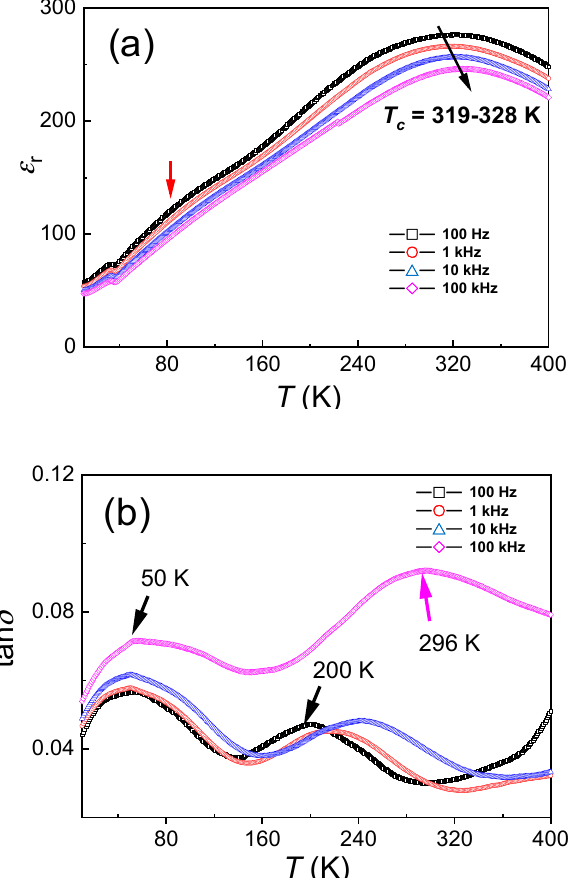
Figure 3. Temperature-dependent (10–400 K) dielectric constant ( ε r ) ( a ) and loss tan δ ( b ) of the BCT-BZT film at a frequency range from 100 Hz to 100 kHz.